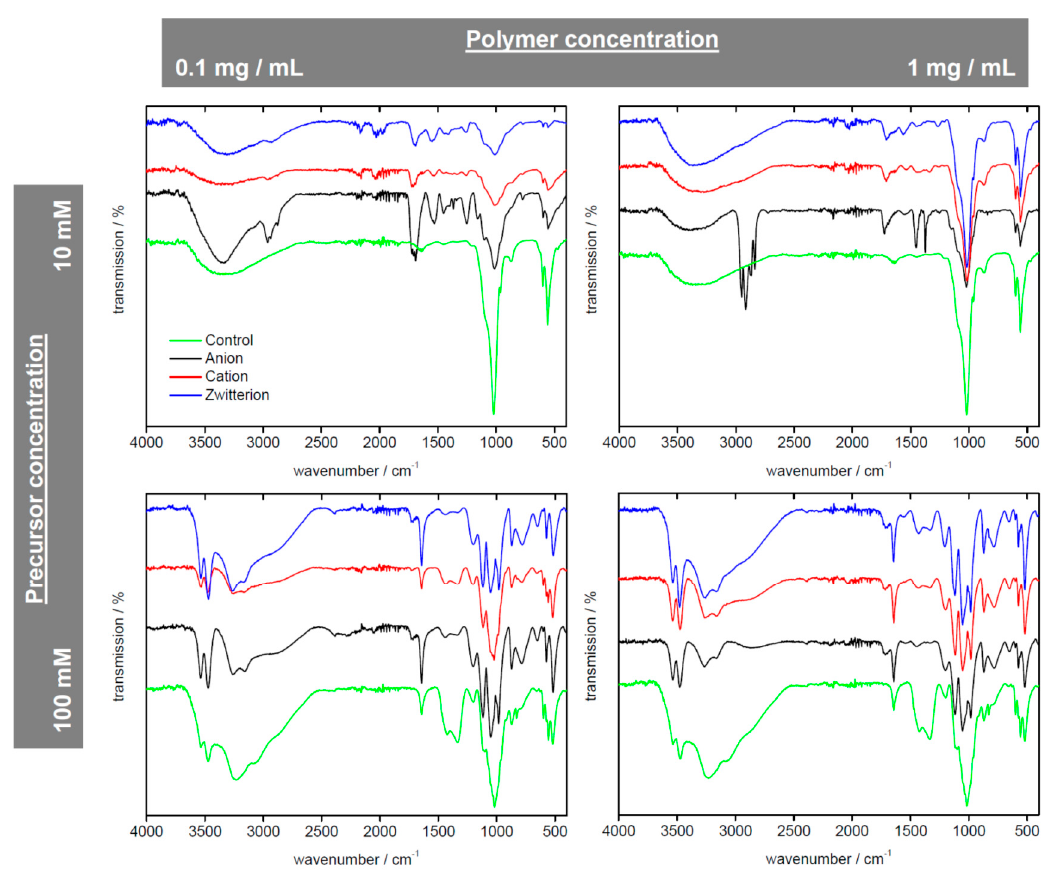
Figure 3. Representative IR spectra of all samples investigated in this study. The color coding applies to all panels in the figure and also to the remainder of the article.